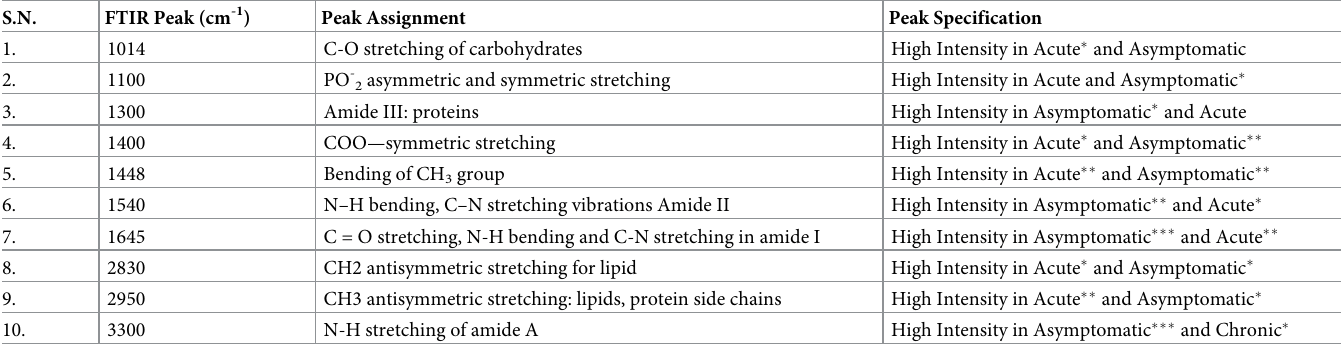
Table 2. Peaks assignment for FTIR spectra of normal and LF